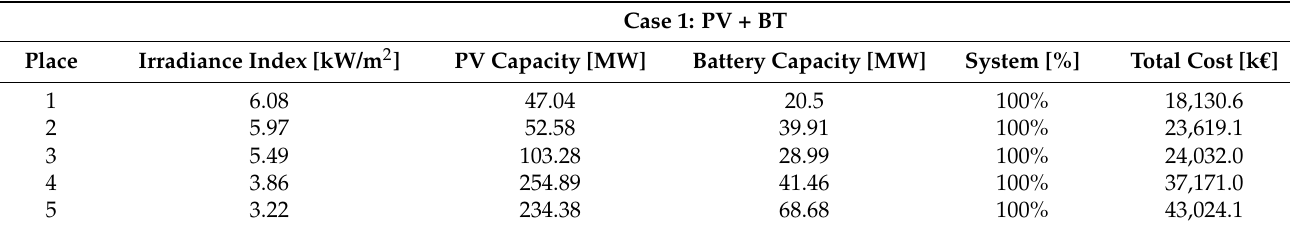
Table 2. Summary of total costs—first scenario.